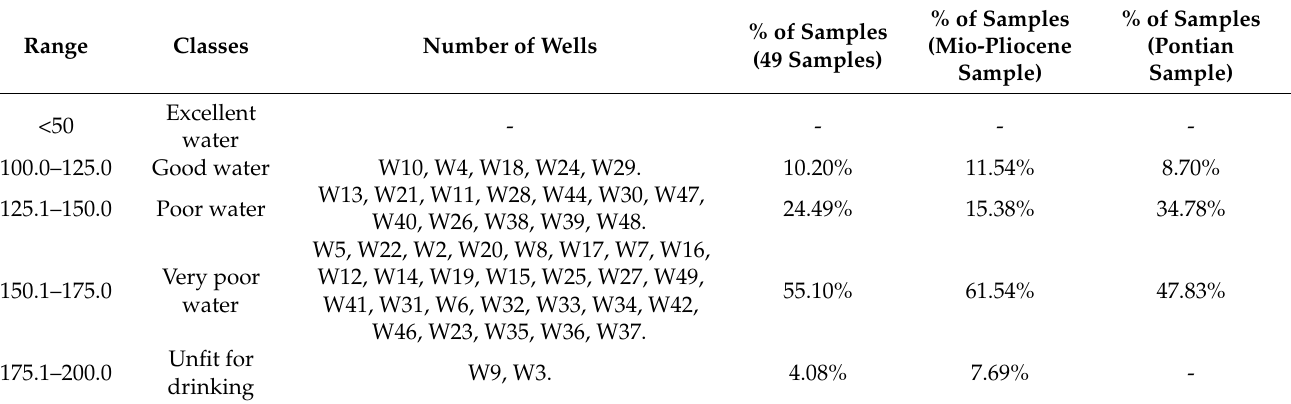
Table 3. WQI-based groundwater suitability for drinking and